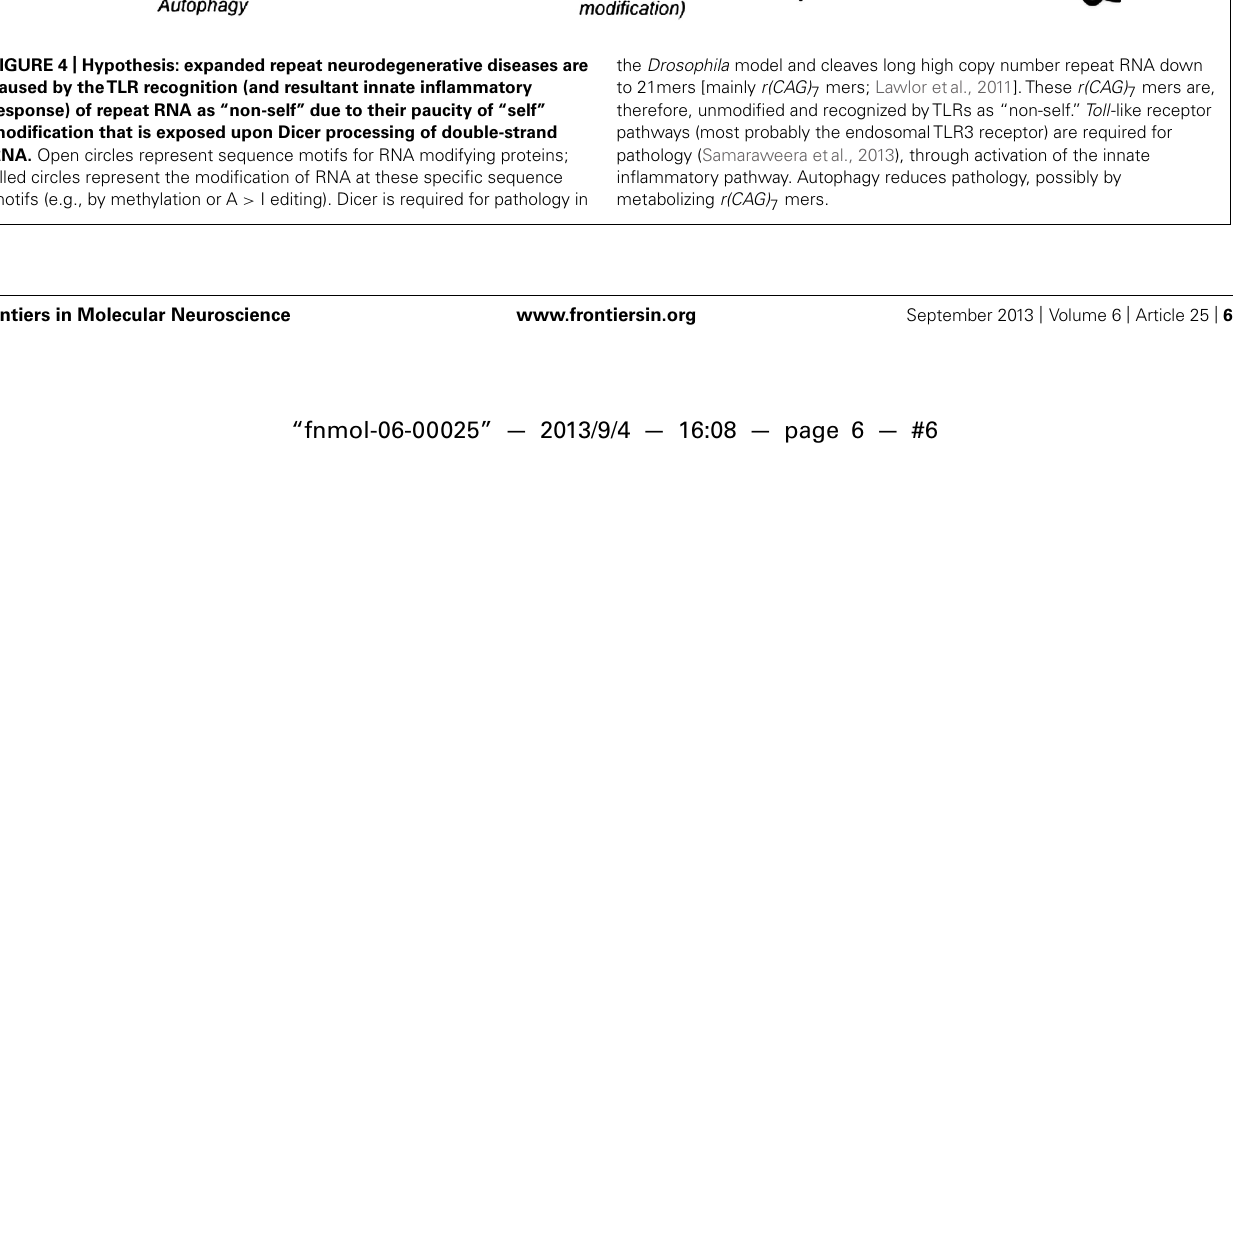
FIGURE 4 | Hypothesis: expanded repeat neurodegenerative diseases are caused by theTLR recognition (and resultant innate inflammatory response) of repeat RNA as “non-self” due to their paucity of “self” modification that is exposed upon Dicer processing of double-strand RNA. Open circles represent sequence motifs for RNA modifying proteins; filled circles represent the modification of RNA at these specific sequence motifs (e.g., by methylation or A > I editing). Dicer is required for pathology in